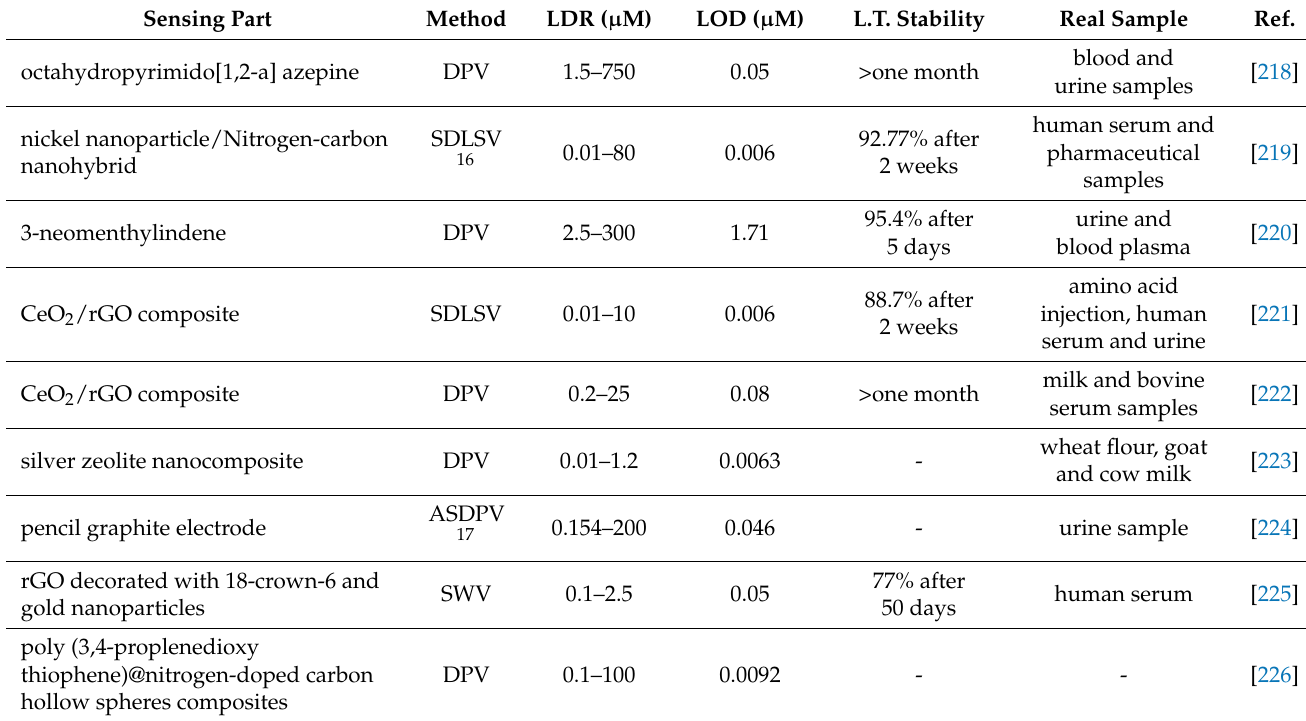
Table 4. Proposed electrochemical tryptophan sensors, since 2010, along with the most important corresponding figures of